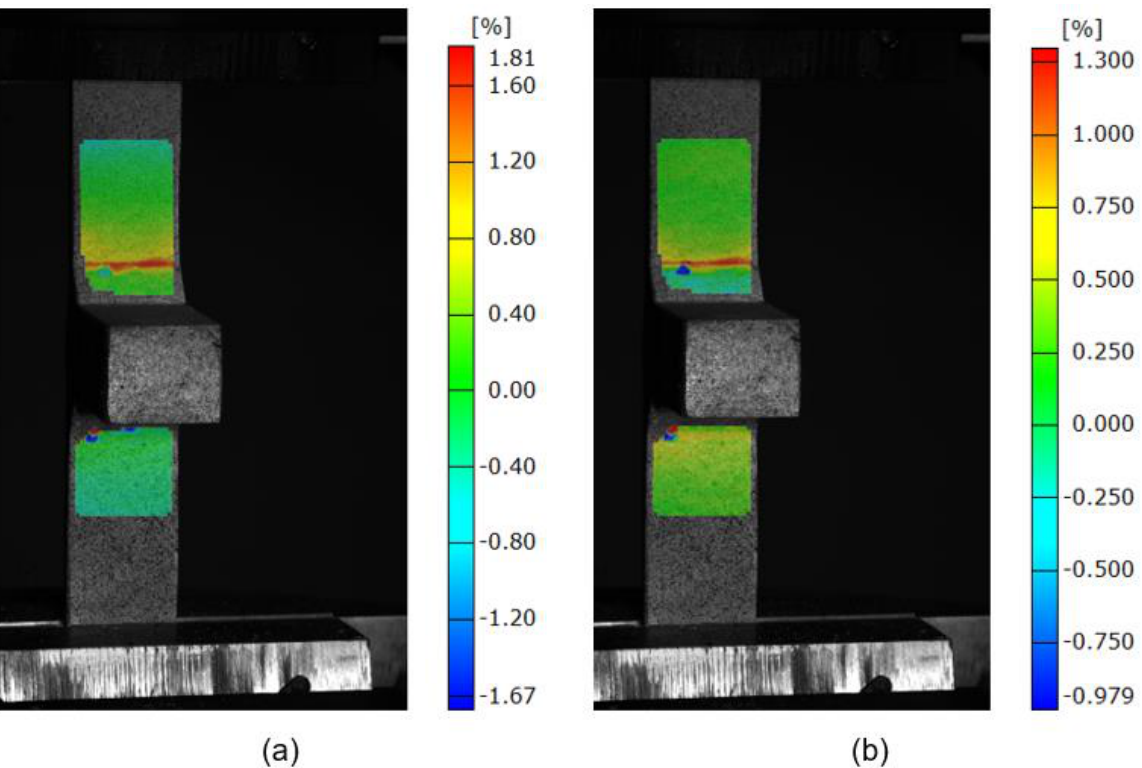
Figure 10. Longitudinal strain map: ( a ) minimum value of displacement and ( b ) maximum value of displacement; (d a = 0.45 mm).